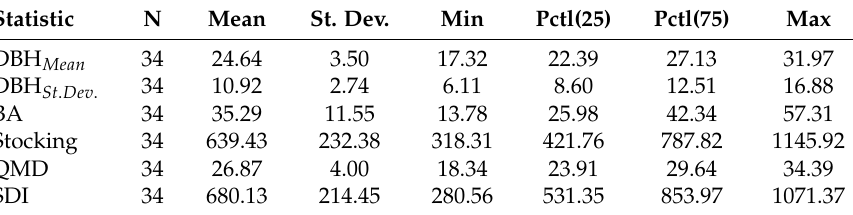
Figure 3. Harvard Forest (HF) EMS flux tower and landcover classes. Table 1. HF-EMS forest inventory summary for the 34 tower plots in 2002; DBH = depth at breast height (cm); BA = basal area per hectare (m 2 ); Stocking = n trees per hectare; QMD = quadratic mean diameter (cm); SDI = Reineke’s stand density index